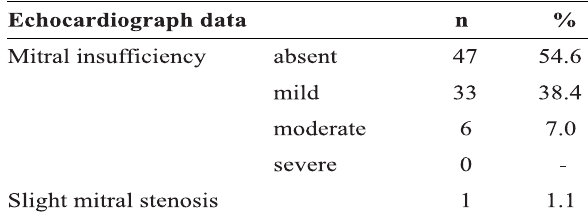
Table 4. Surgical procedures for mitral valvuloplasty Table 5. Post-operative echocardiograph variations.